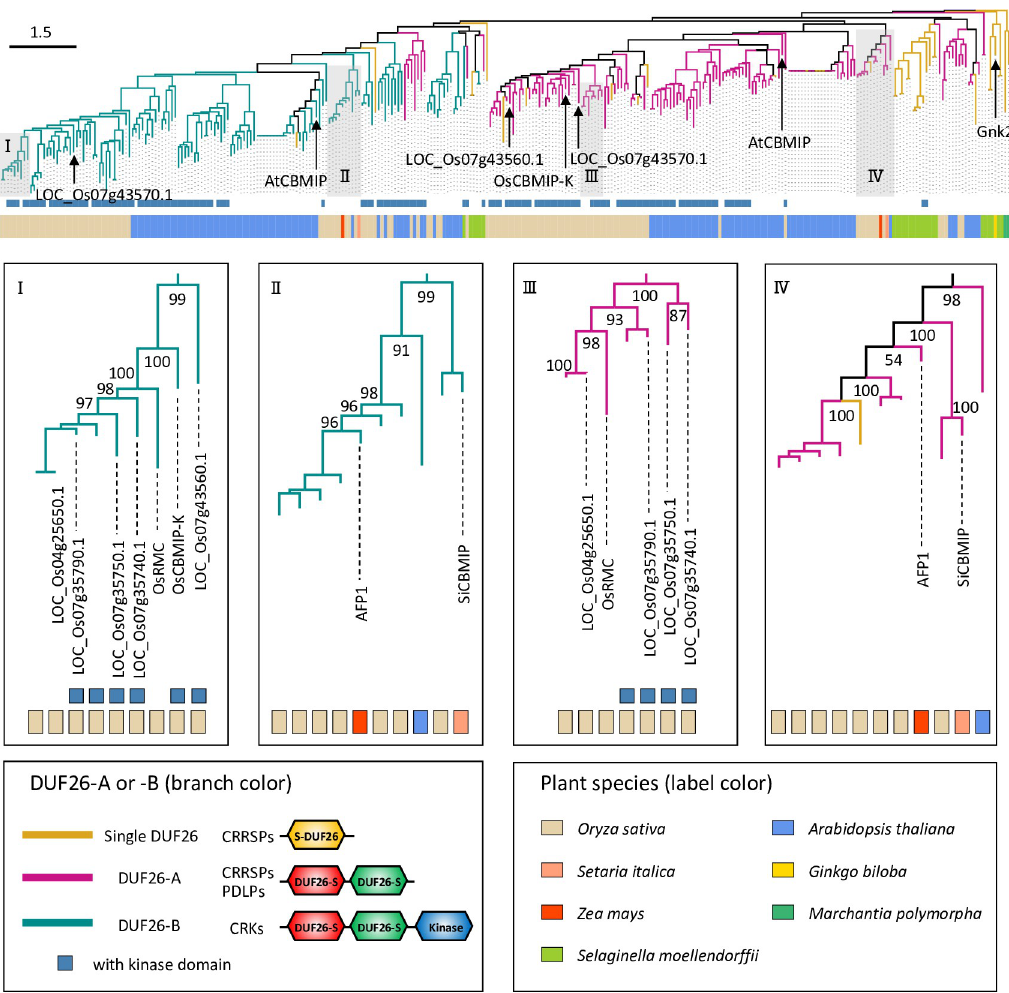
Fig 8. Phylogenetic analysis of CBM1-binding proteins. Phylogenetic tree reconstructed using a single DUF26, DUF26-A and DUF26-B domains of CRRSPs and CRKs from O . sativa , A . thaliana , Selaginella moellendorffii , and M . polymorpha , and Gnk2, SiCBMIP, and AFP1. Bar, 1.5 amino acid substitutions per